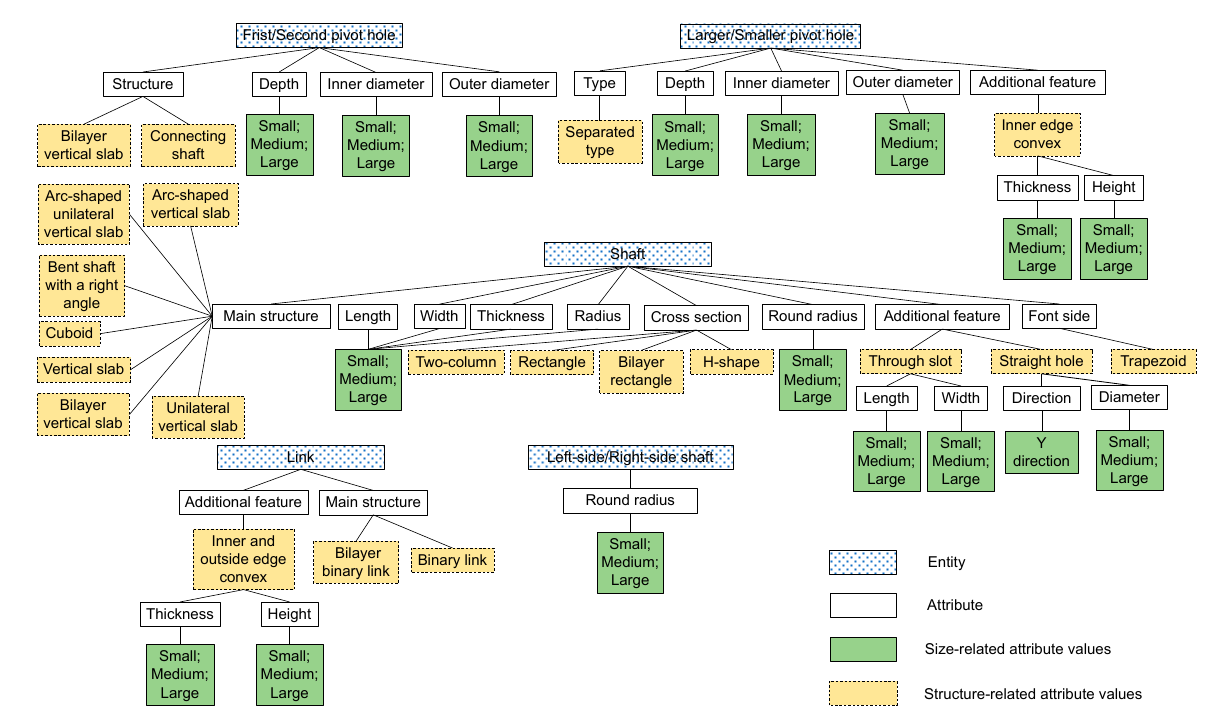
Figure 3. The key structural features that determine the 3D shapes of linking rods.